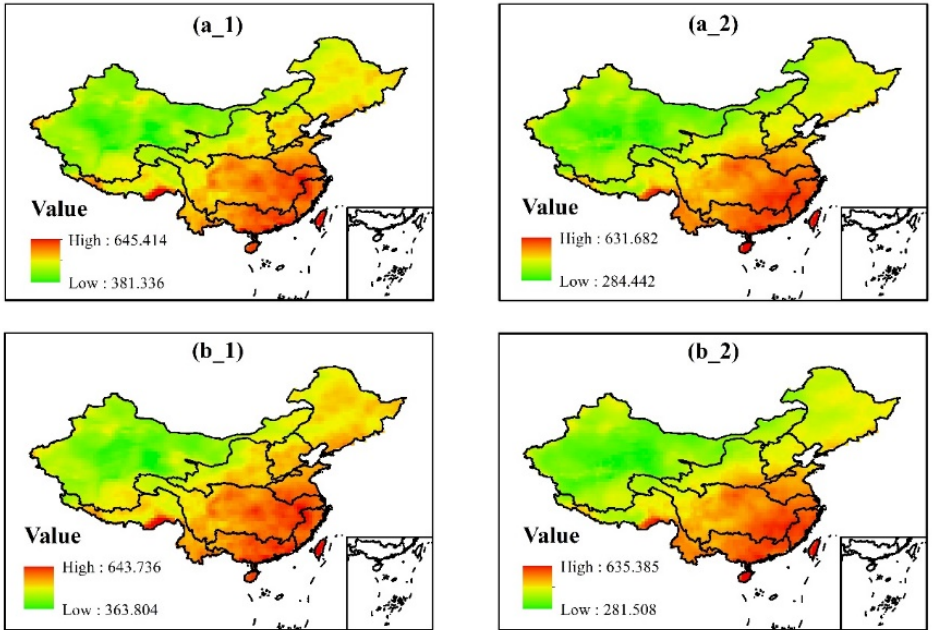
Figure 3. Performances of nonstationary and stationary models under AIC assessment. ( a ) and ( b ) are the stationary and nonstationary models, respectively; ( 1 ) and ( 2 ) are the AIC values for the seventh and fifth-months, respectively.